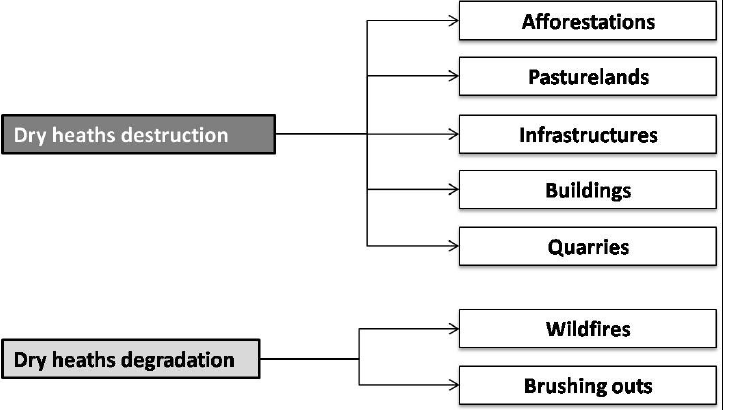
Figure 3. Causes of destruction and degradation of the habitat type European dry heaths (Nat-2000 4030) identified in SCI Os Ancares–O